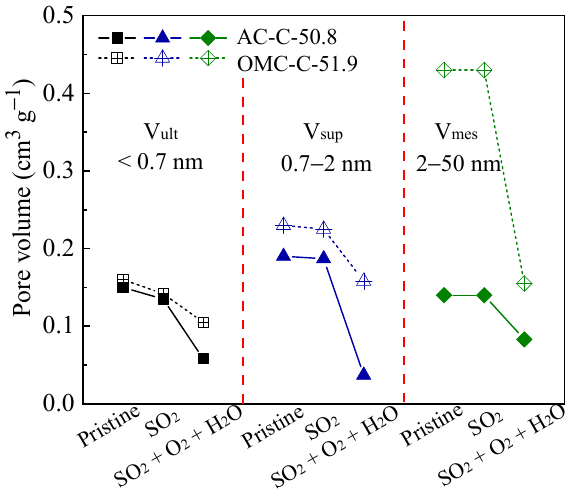
Figure 6. Pore volume parameters of fresh adsorbents (pristine), adsorbents after adsorption of SO 2 separately (SO 2 ) and adsorbents after reaction under SO 2 + O 2 + H 2 O conditions. Samples: AC-C-50.8 and OMC-C-51.9. Pore volume parameters: V ult , supermicropore volume (V sup , 0.7–2 nm) and V mes , and the V sup obtained by (V mic –V ult ).